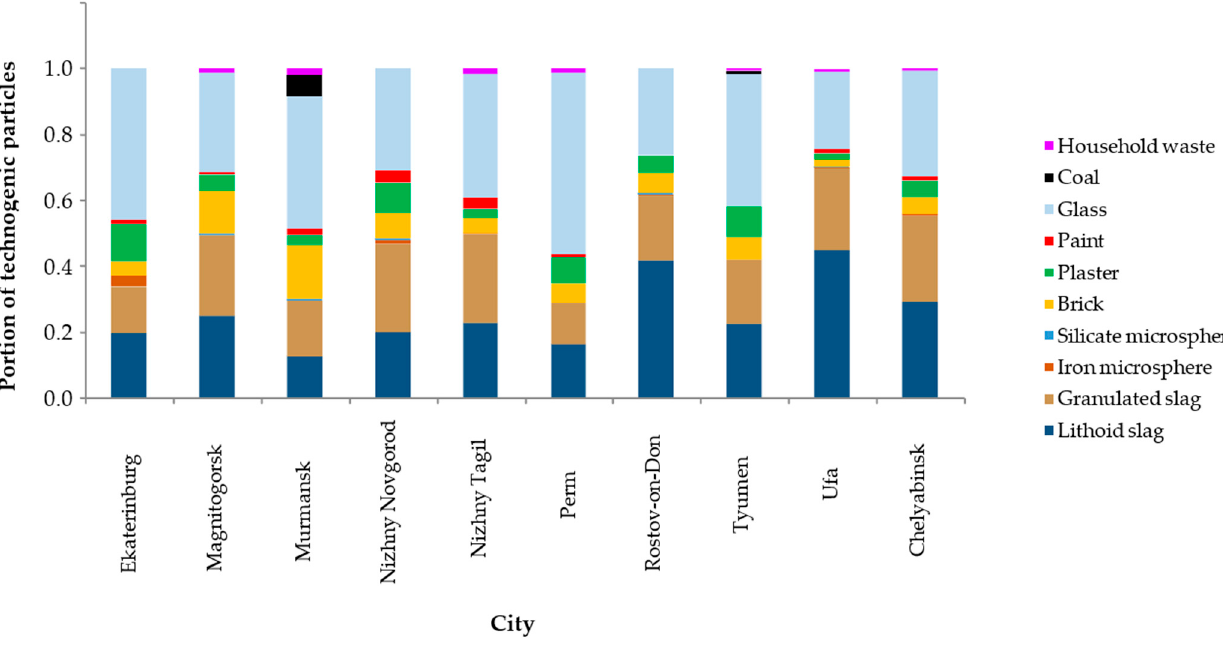
Figure 6. Distribution of the amount of different types of technogenic particle in the cities in the granulometric fraction of 0.25–1 mm.